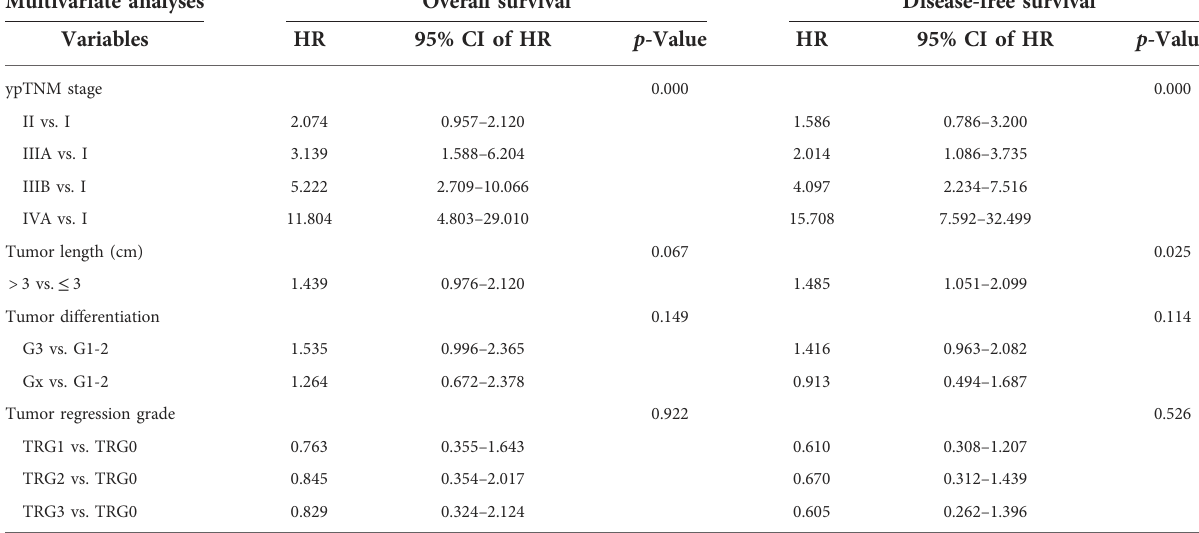
TABLE 4 The multivariate analysis of overall survival and disease-free survival. Multivariate